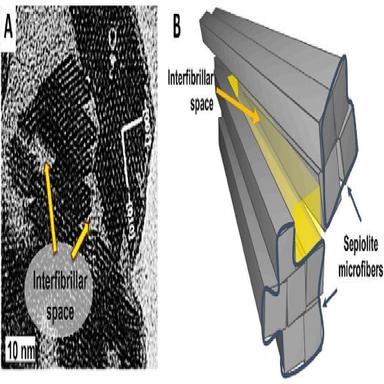
a) HR-TEM image of the cross-section of a sepiolite fiber showing the presence of structural tunnels and interfibrillar spaces between elemental fibers (modified image, reprinted from with permission from Elsevier); b) Schematic representation of the arrangements of microfibers components of a sepiolite bundle.